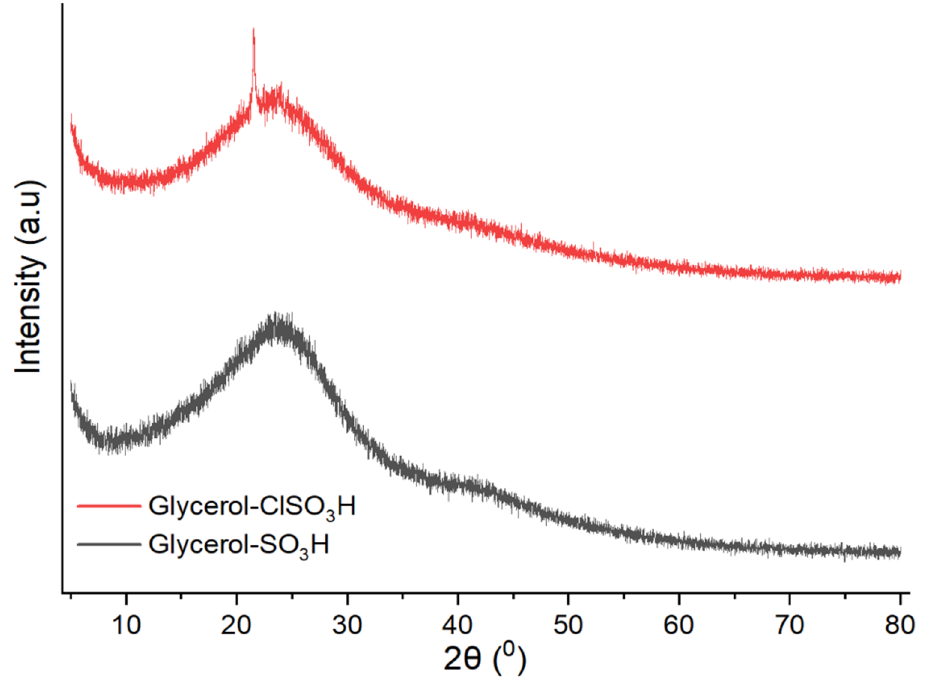
Figure 5. XRD signal analysis of acidic glycerol catalyst samples.